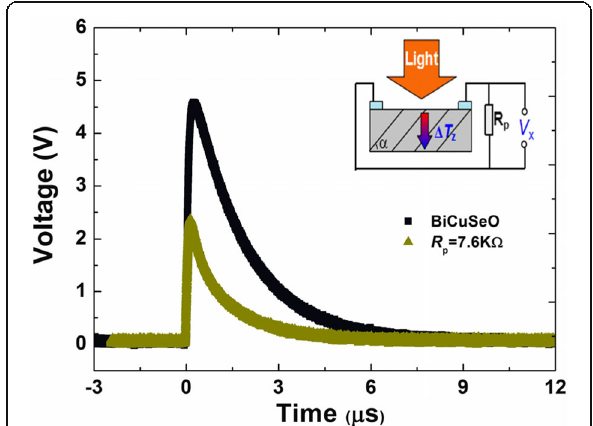
Figure S2. (a) SEM surface image of a 20nm-thick AuNPs layer and (b) Voltage response of AuNPs(20 nm)/BiCuSeO to the 308nm pulsed light irradiation. For comparison, data of bare BiCuSeO is also provided.